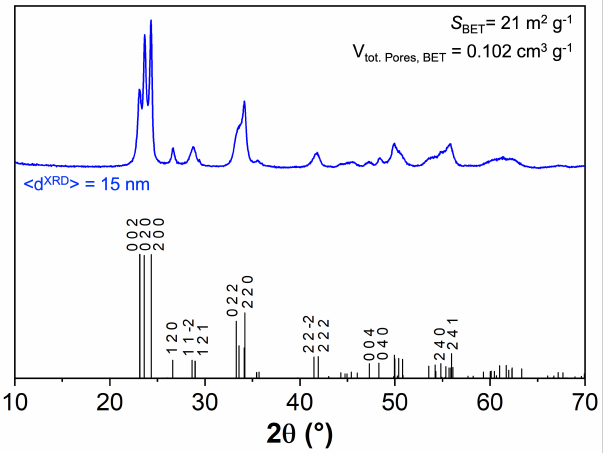
Figure 1. WO 3 XRPD pattern in which the main peaks are assigned to Miller’s indexes (International Centre for Diffraction Data–ICDD n. 01-075-2072). Average crystallite domains size (<d XRPD >), specific surface area ( S BET ), and total pores volume (V tot. pores ) are also